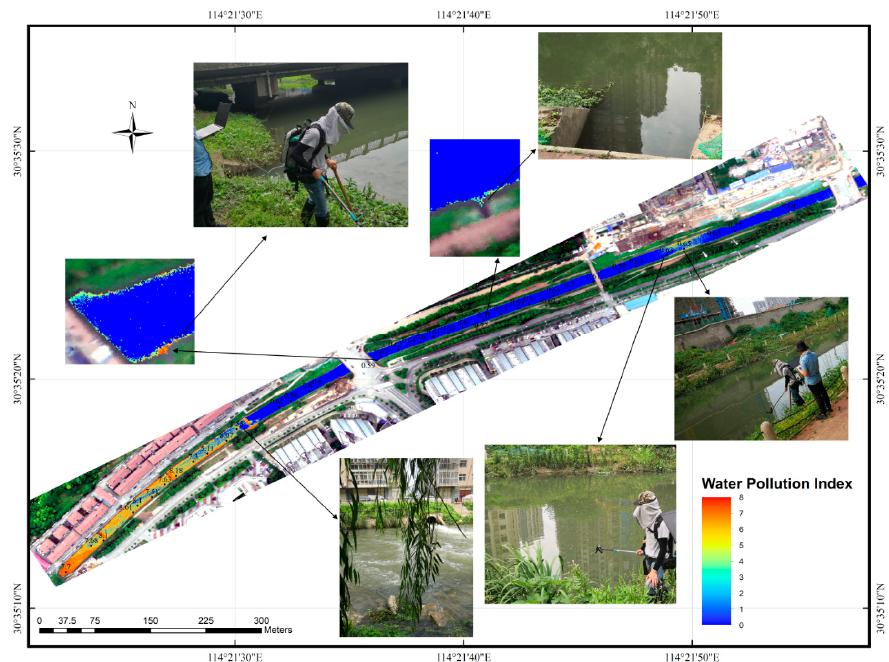
Figure 14. Inversion results for the Nemerow index based on GBDTR in the Shahu Port dataset.